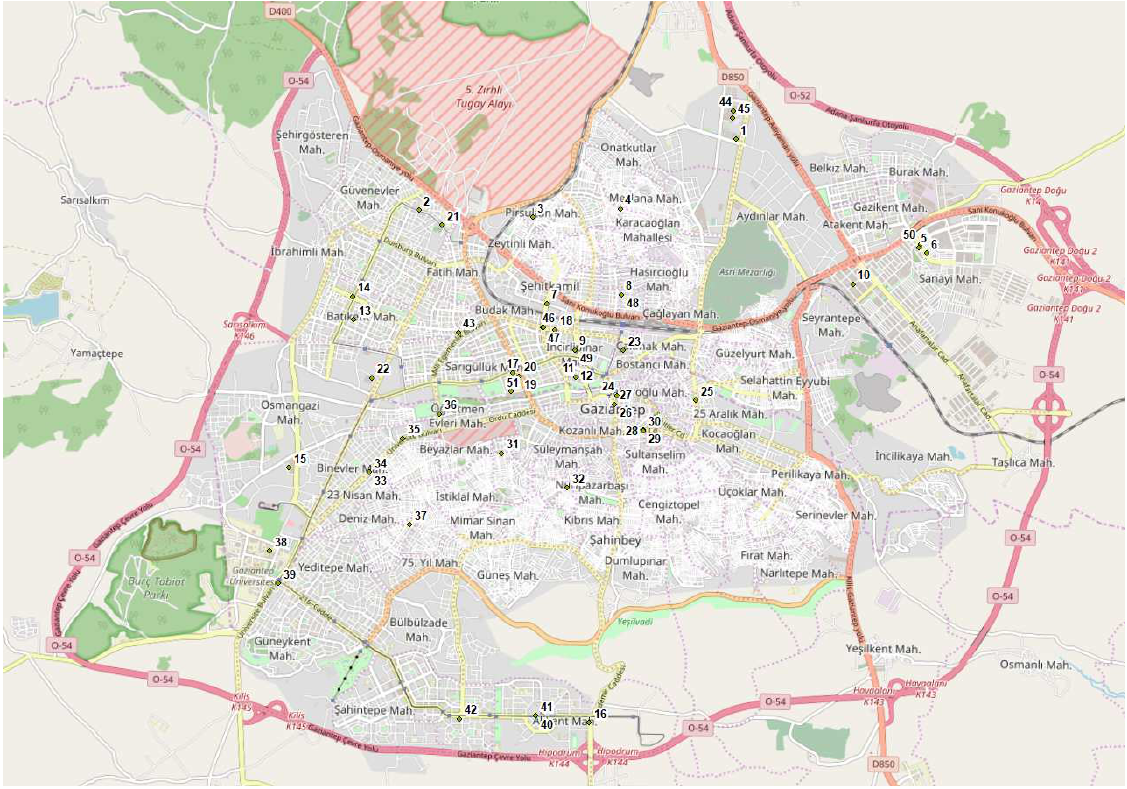
Figure 3. Locations of